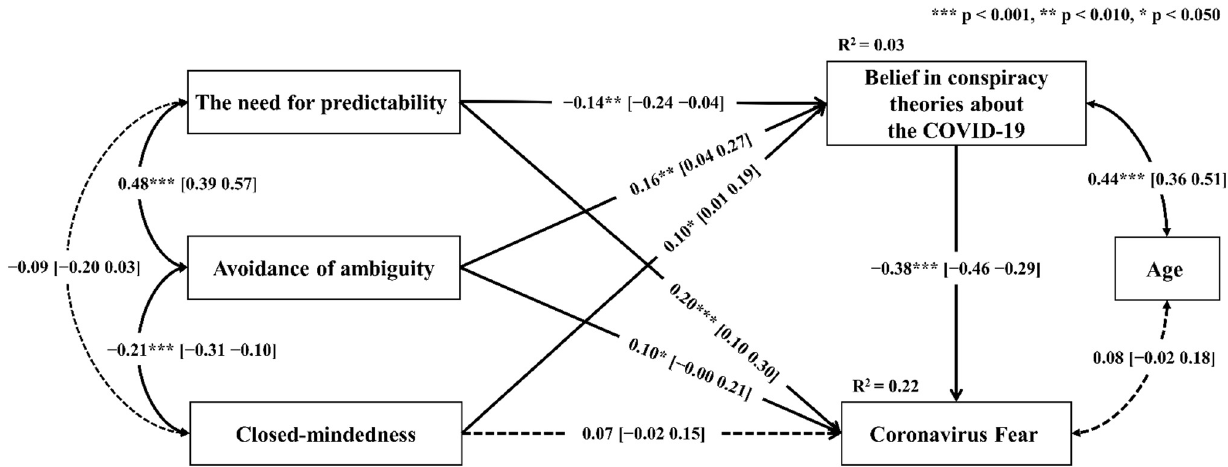
Figure 1. Paths model of relationships between the need for closure dimensions, belief in conspiracy theories about the COVID-19, age, and fear of the coronavirus ( n = 380). The dashed line indicates statistically insignificant relationships.